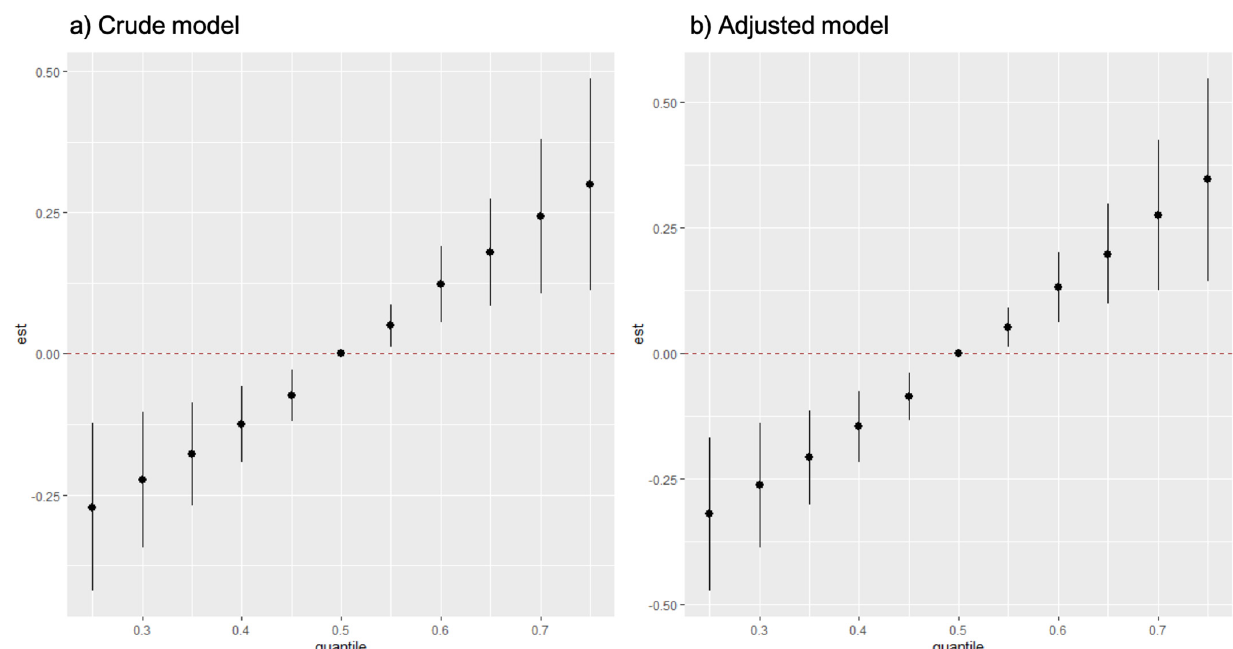
Figure 2. The cumulative effect of 15 REEs in the BKMR model. ( a , b ) showed the overall effect of the crude model and the adjusted model, respectively. The P 50 level of the mixture showed significant differences from other levels and showed linear trends as the levels increased in both ( a , b ).